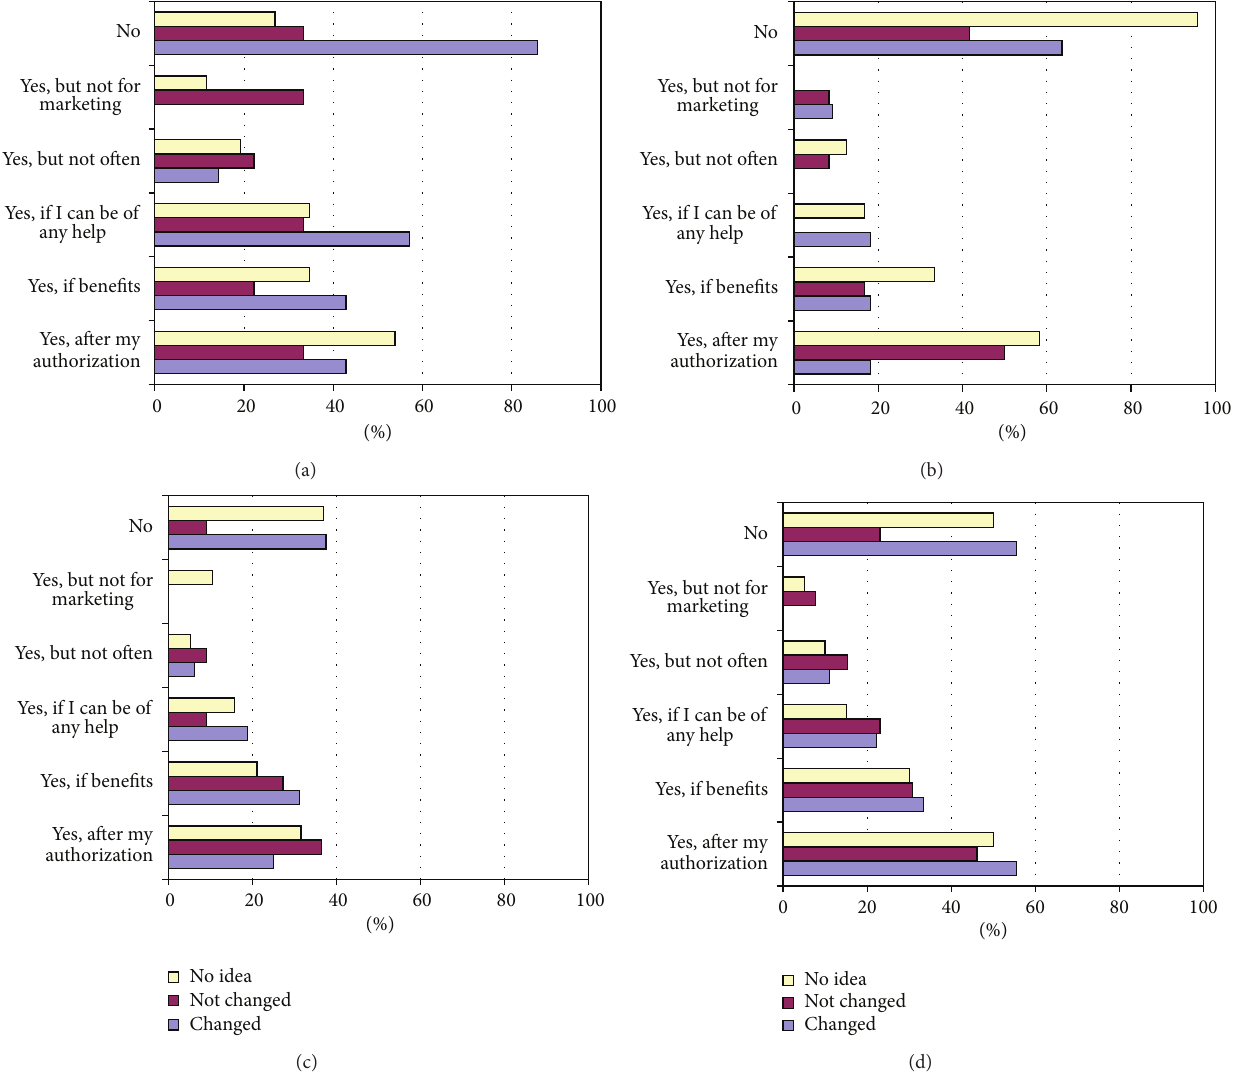
Figure 20: Will to be contacted according to privacy settings changes: (a) DN men; (b) DN women; (c) DI men; (d) DI